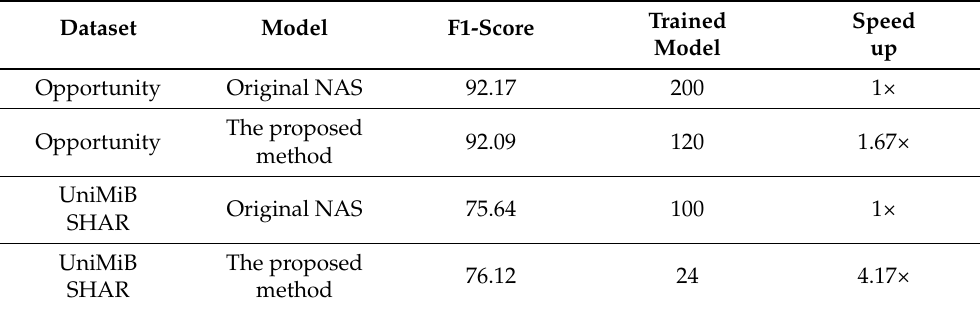
Table 7. Efficiency comparison between the NAS model with surrogate model or